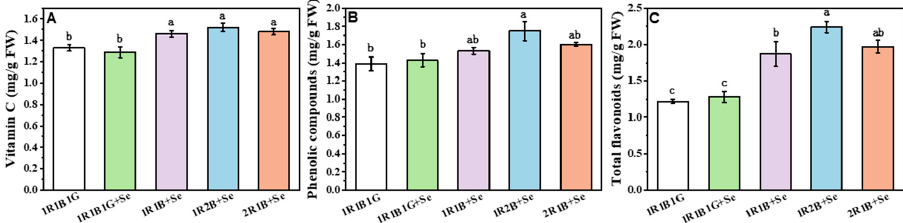
Figure 2. The content of Vc ( A ), TPC ( B ) and TF ( C ) of broccoli sprouts grown under a combination of selenium and LED light quality treatments. The letters marked in all figures indicate the significance of the difference ( p ≤ 0.05, Duncan’s test).